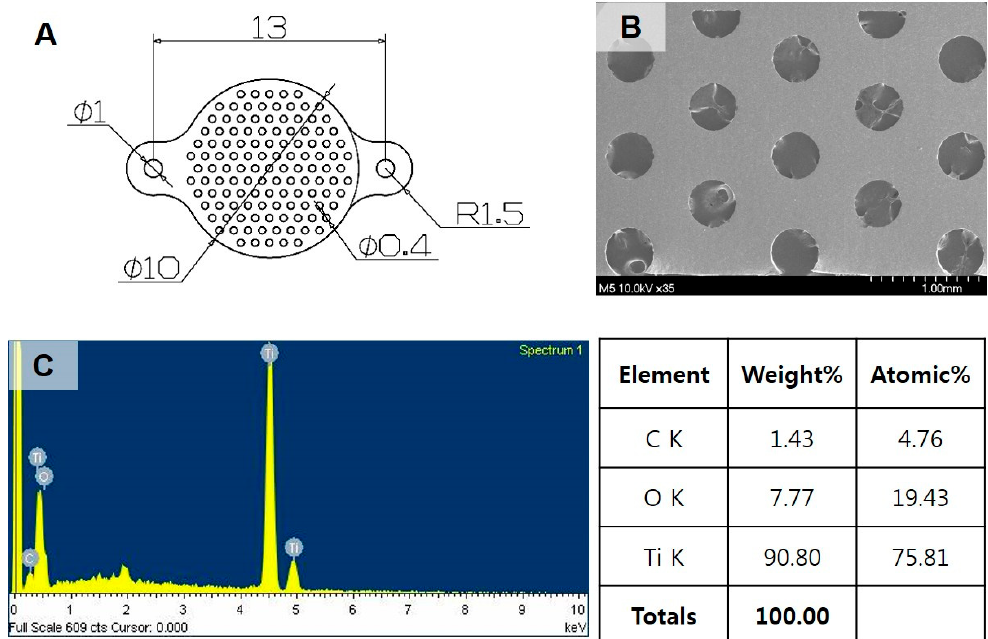
Figure 9. Characterization of pristine Ti mesh. ( A ) Technical drawing; ( B ) Field emission scanning electron microscopy (FE-SEM) images: perforated Ti mesh with multiple holes; ( C ) EDS analysis of the chemical composition of the Ti mesh.